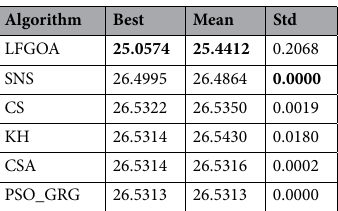
Table 28. Comparative results of LFGOA with other methods for tubular column. The best of the comparison results are in